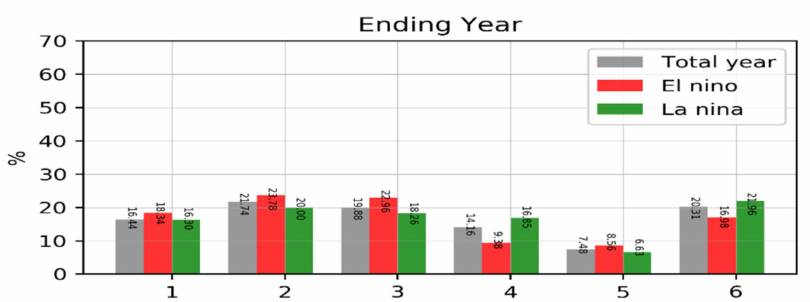
Figure 14. Frequencies of the WTs in all years (grey), El Niño years (red), and La Niña years (green) in March–May following the ENSO peak (i.e., in the ENSO ending year,